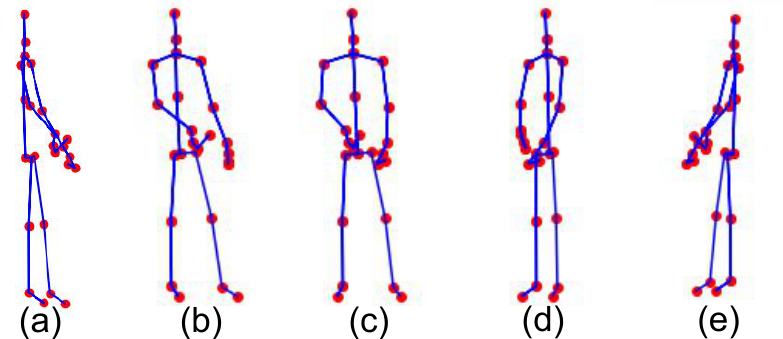
Figure 3. A raw skeleton that has been transformed using a simple rotation transformation by an angle θ : ( a ) θ = 90 ◦ , ( b ) θ = 45 ◦ , ( c ) θ = 0 ◦ (raw skeleton), ( d ) θ = − 45 ◦ , ( e ) θ = − 90 ◦ . Note that for illustrative purposes, z -coordinate that corresponds to depth information has been